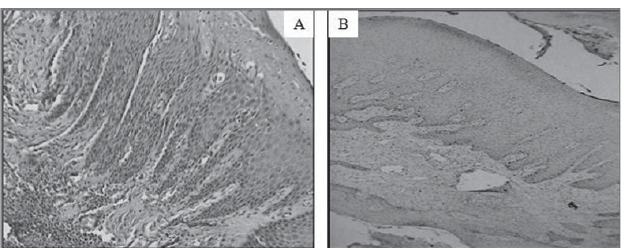
Fig. 6 H/E (A) and IHC staining with p53 expression (B) showing moderately differentiated squamous cell carcinoma